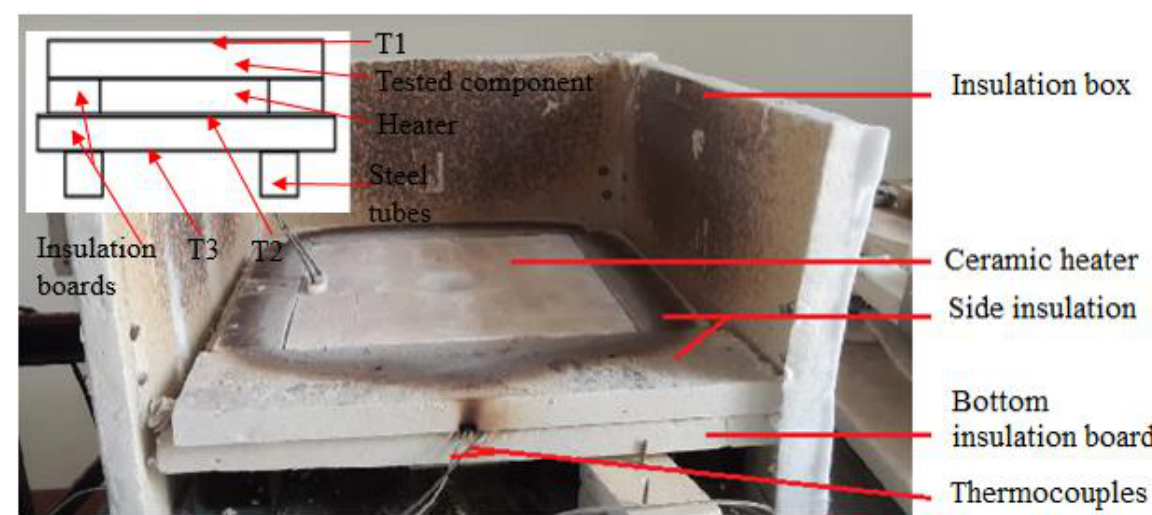
Figure 3. Insulation box with heater (open).